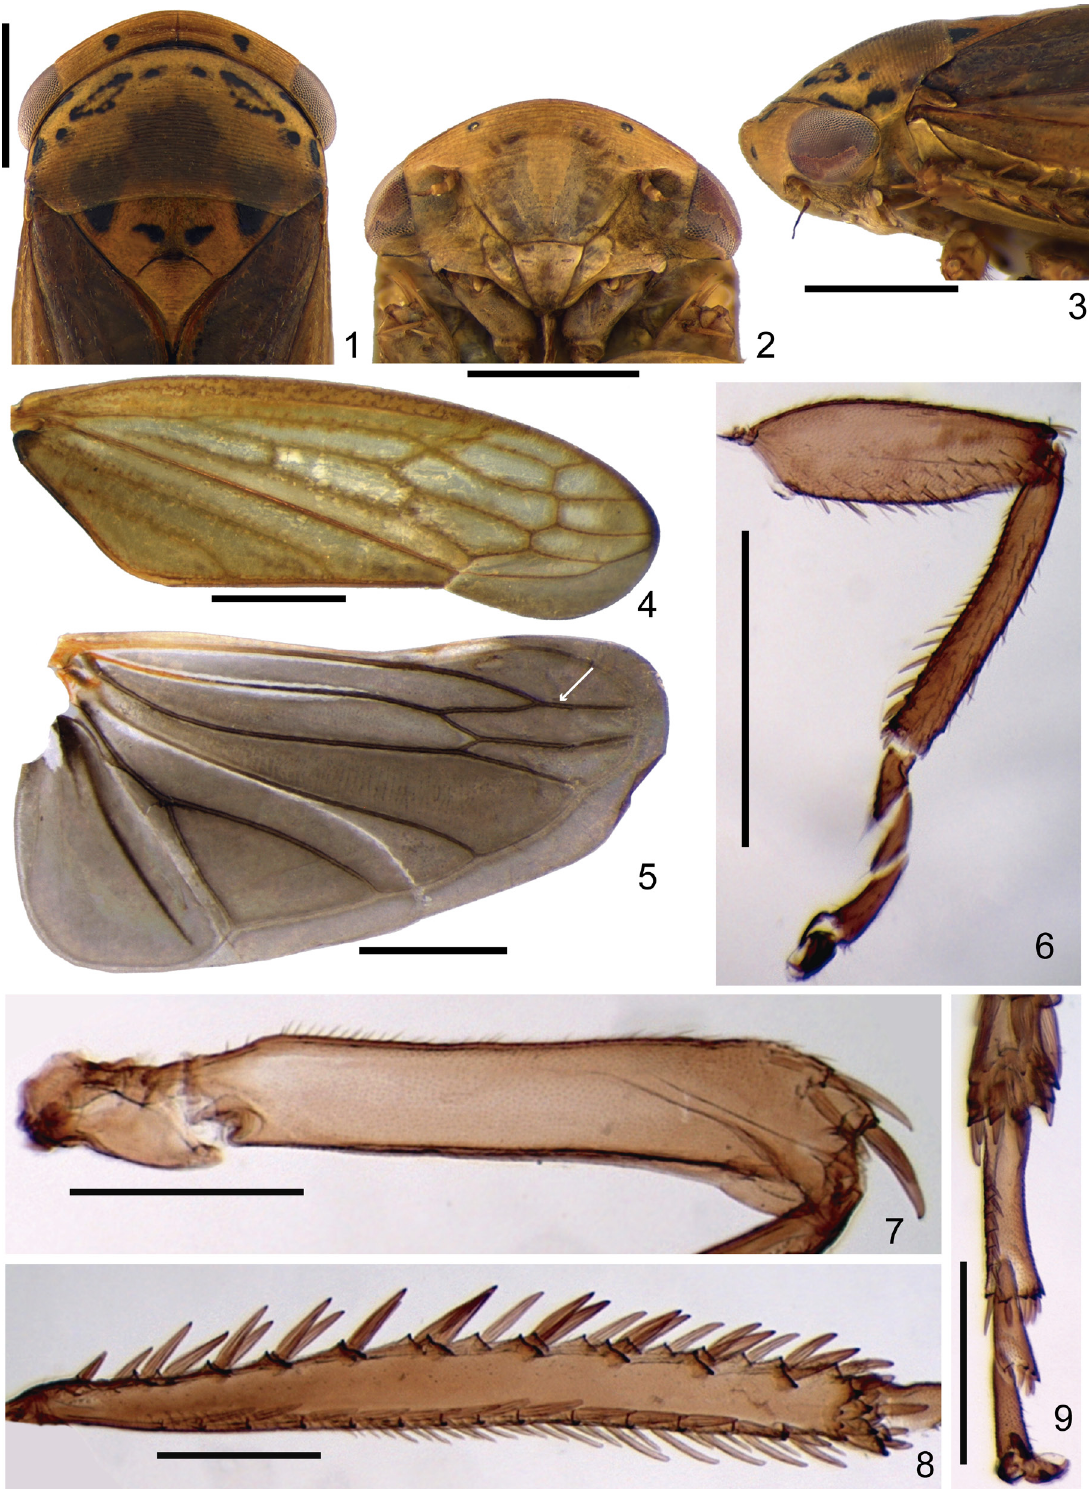
Figs 1–9. Guaricicana borgesi gen. et sp. nov., holotype, ♂ (DZUP 215374). External morphology. 1 . Head and thorax, dorsal view. 2 . Head and thorax, ventral view. 3 . Head and thorax, lateral view. 4 . Fore wing. 5 . Hind wing. 6 . Fore leg, anterior view. 7 . Hind femur, anterior view. 8 . Hind tibia, anterior view. 9 . Hind tarsus, ventral view. Scale bars: 1–7 = 1.0 mm; 8–9 = 0.5